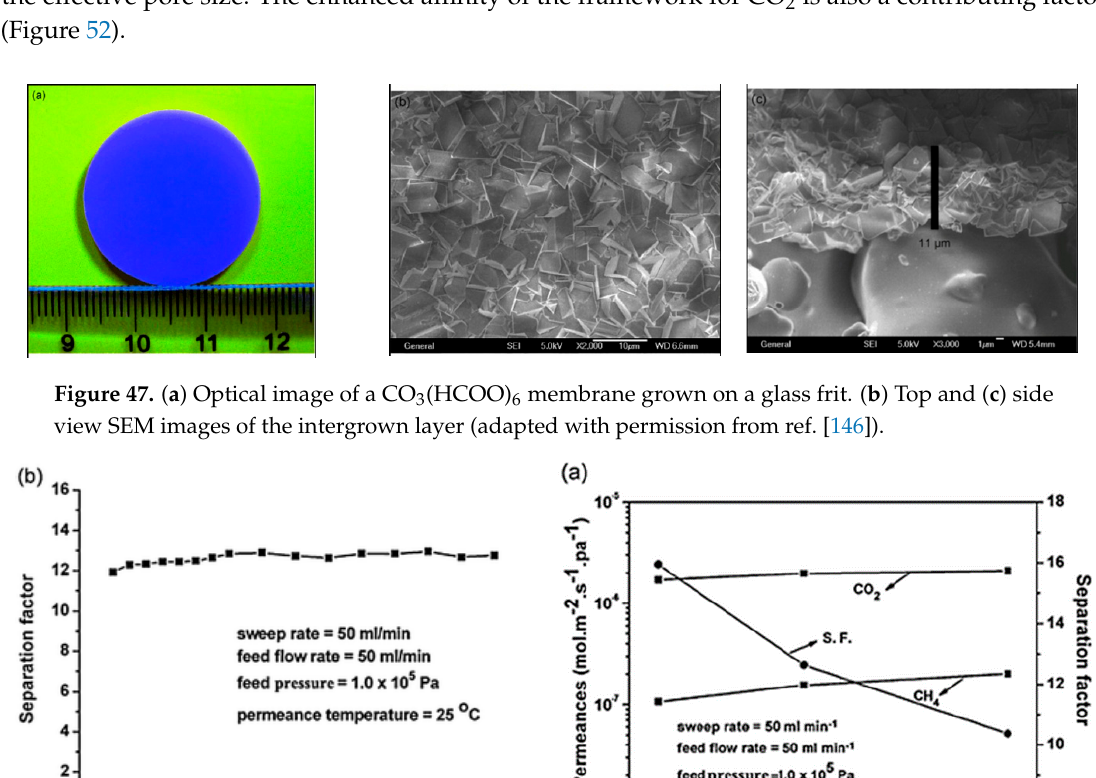
Figure 47. ( a ) Optical image of a CO 3 (HCOO) 6 membrane grown on a glass frit. ( b ) Top and ( c ) side view SEM images of the intergrown layer (adapted with permission from ref. [146]).